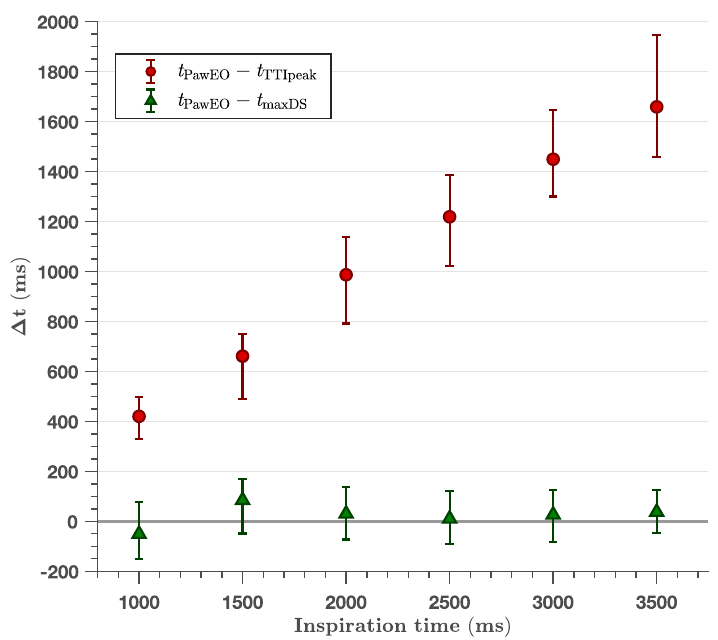
Figure 3. Effect of inspiratory time in the time differences between the TTI fiducial points (TTI peak, t TTIpeak , and maximum downslope, t maxDS ) and the peak pressure time in the Paw line marking exhalation onset ( t PawEO ). All ventilator settings had a constant tidal volume of 400 mL and frequency of 10min − 1 . Data is shown as median with first to third quartile interval. There was a linear relation with positive slope 0.47 for the TTI peak, and no relation with a median time difference for maximum downslope ( R 2 < 0.01).